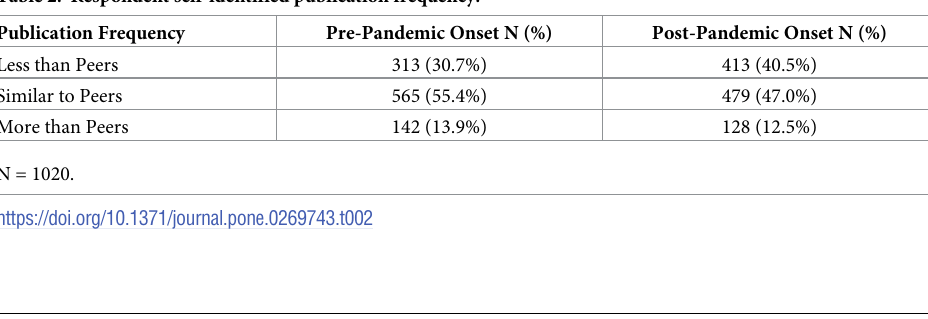
Table 2. Respondent self-identified publication